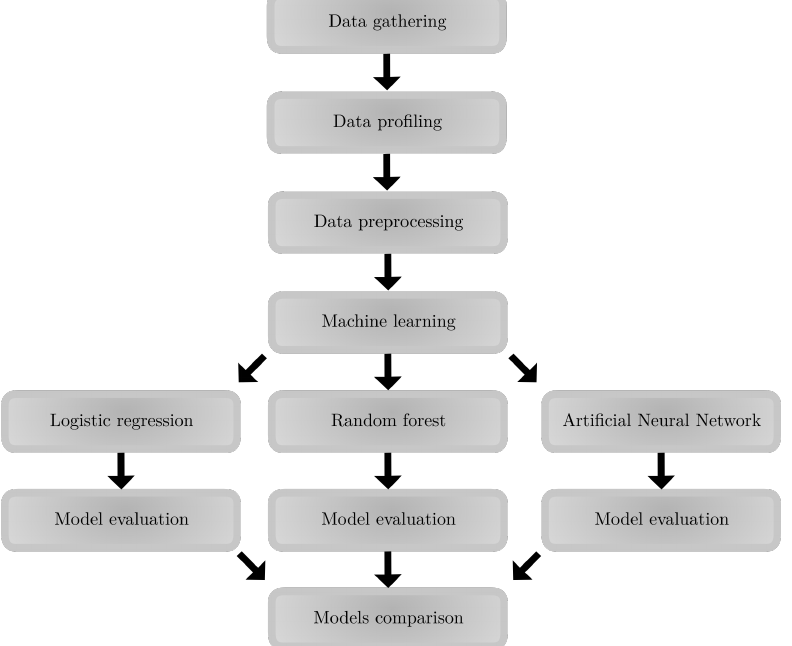
Figure 1. The proposed approach for predicting the overall HDD project outcome and the occurrence of the identified unwanted